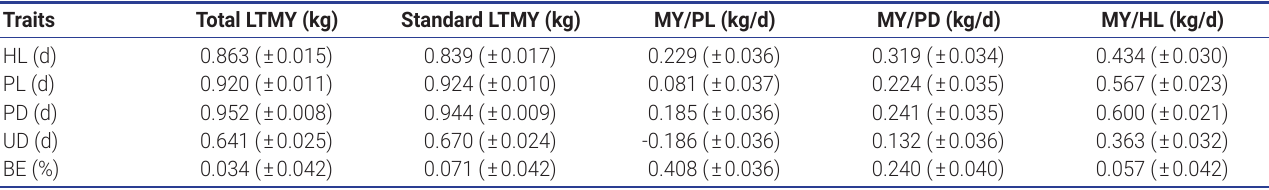
Table 8. Phenotypic correlation among lifetime traits in Murrah buffaloes Traits